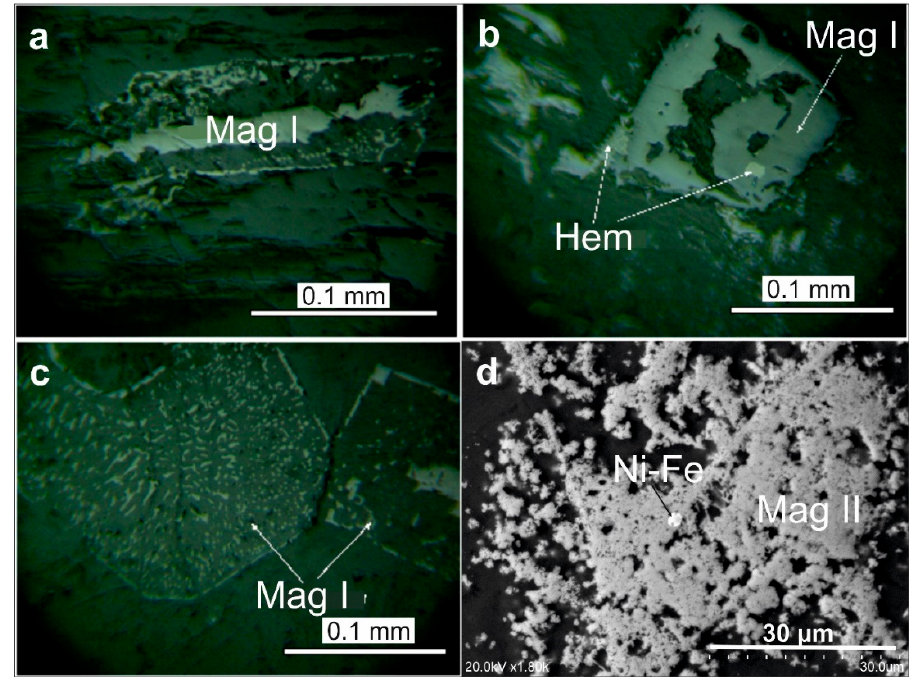
Figure 6. ( a ) Magnetite I that has replaced an elongated pyroxene crystal (wehrlite, sample 3/1, Burlakski pluton). ( b ) Isometric idiomorphic magnetite I grain replaced by later hematite (serpentinite, sample 3/7, Burlakski pluton). ( c ) Symplectic texture of magnetite I (wehrlite, Sample 3/1, Burlakski pluton). ( d ) Dusty grains of magnetite II associated with awaruite (Ni–Fe). Mag, magnetite; Hem,